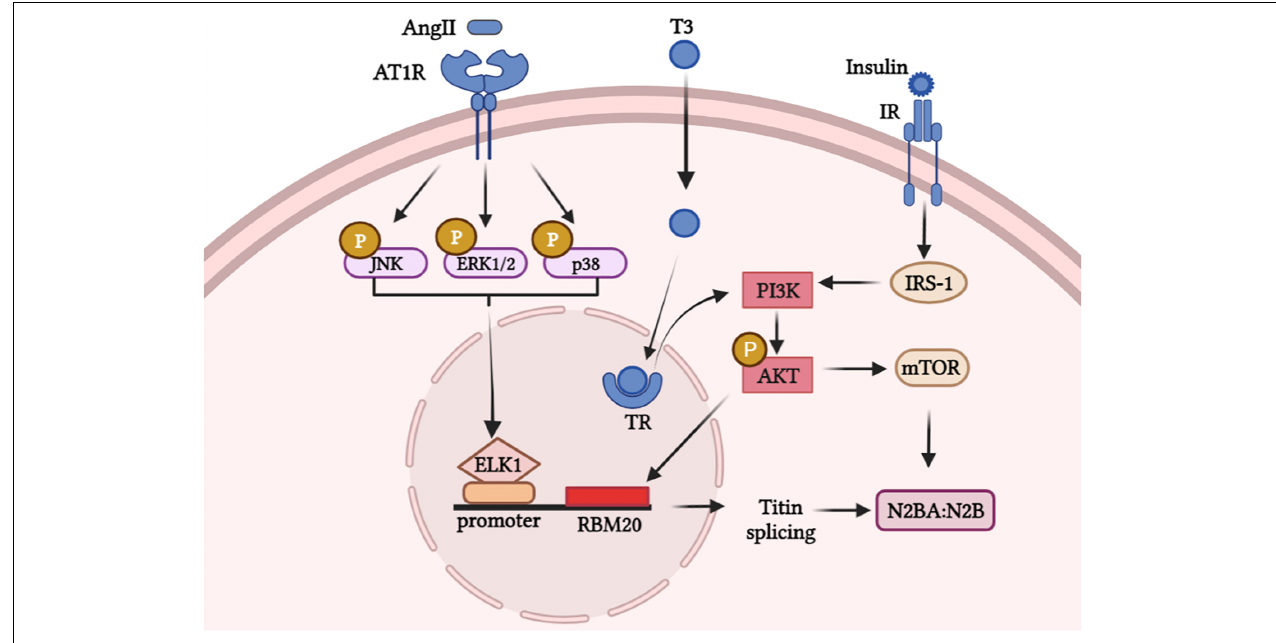
FIGURE 2 | Hormone stimuli promote signaling pathways in modulating the expression of titin isoforms via